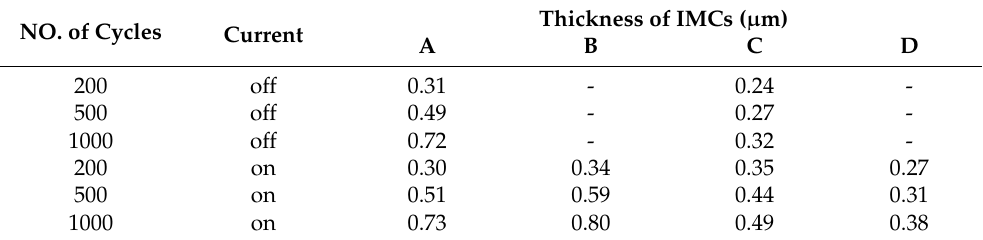
Table 1. The thickness of IMCs at different interfaces under thermal cycling.